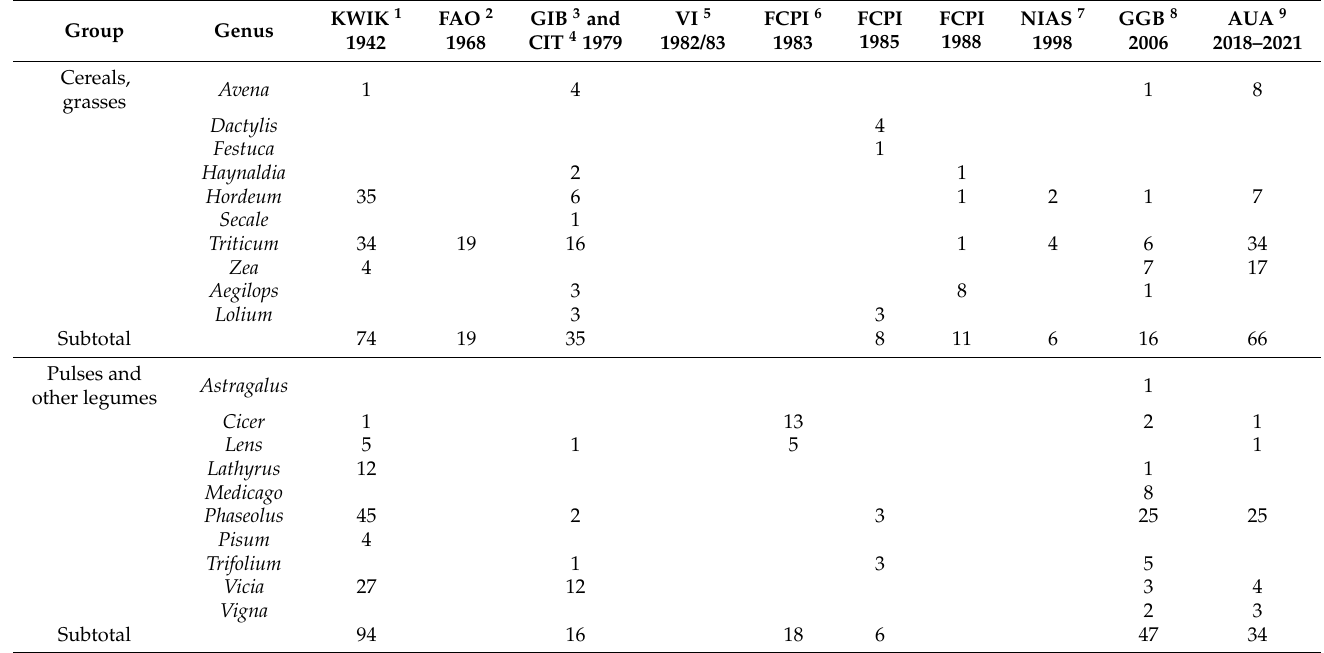
Table 1. Collection missions made in Arcadia prefecture by different institutions from 1942 to 2021.